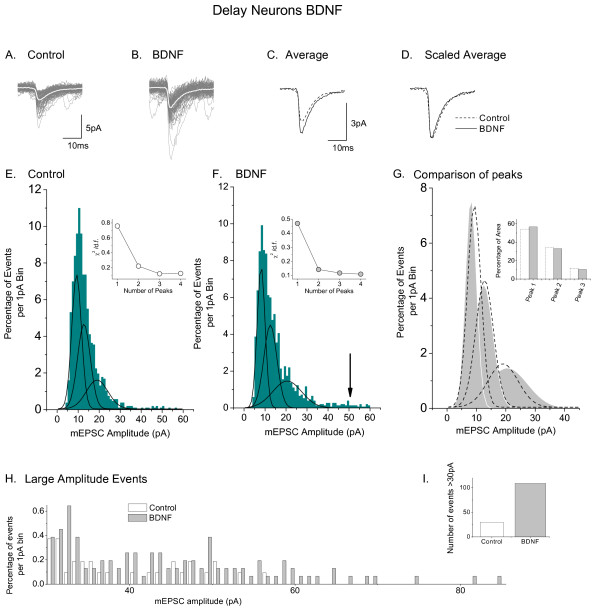
Analysis of the effects of BDNF on mEPSCs of delay neurons (in vitro). A. Superimposed recordings of 3 min of mEPSC activity in a control delay neuron; average of events presented as superimposed white trace. B. Similar superimposed recordings from a delay neuron in a BDNF-treated culture. C. Averaged events from the neurons illustrated in A and B. D. Averaged events normalized to control size. Note no change in the rate of decay of current. E. Distribution histogram (1 pA bins) for amplitudes of 1074 mEPSCs from control delay neurons. Fit of the data to three Gaussian distributions represented by black lines. F. Similar histogram and fit to three Gaussian functions for 1554 mEPSCs from BDNF treated neurons; arrow points out small number of very large events that appear in BDNF. Insets in E and F, graphs to show effect of number of Gaussian fits (peaks) on the value of χ2 divided by the number of degrees of freedom. G. Superimposition of the three Gaussian peaks obtained in E with those obtained in F. Inset, comparison of area under curves for the three peaks. H. Data for control and BDNF mEPSCs >30 pA replotted and compared on the same axes. I. Comparison of number of mEPSC events in control and BDNF treated larger than 30 pA. Modified from reference [24] and used with permission of the Physiological Society.